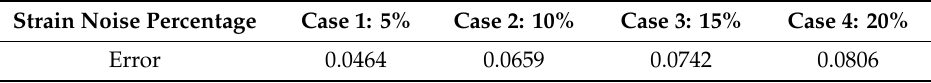
Table 3. Error comparisons for measured displacement in di ff erent noise cases.